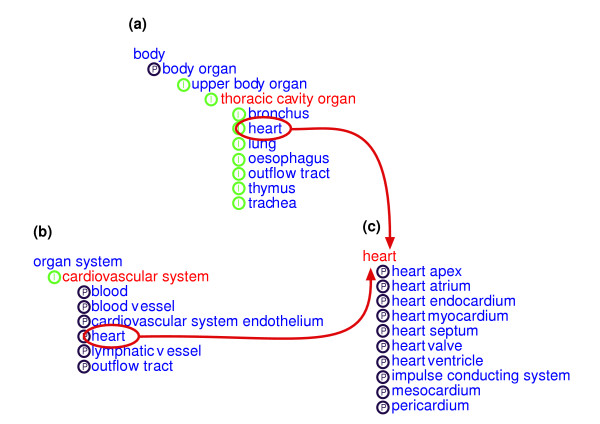
Example showing multiple hierarchical representations for a given anatomical term. The heart is represented both as (a) an organ in the thoracic cavity, and (b) as a part of the cardiovascular organ system. (c) Detail page for the term heart showing immediate substructures. Note that both spatial and functional representations contain is-a and part-of relationships.